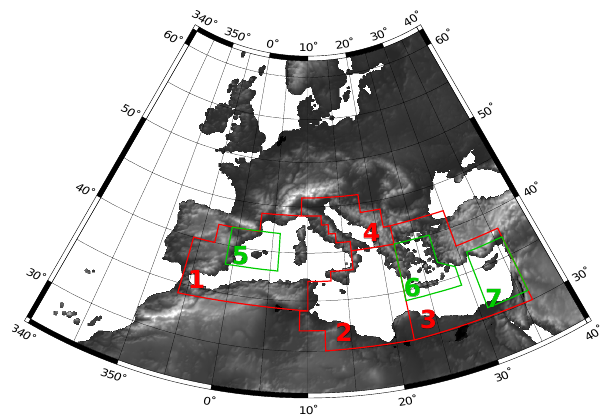
Fig. 1. Definition of the Mediterreanean basin and the seven sub- basins. (1) Western Mediterranean, (2) Central Mediterranean, (3) Eastern Mediterranean, (4) Adriatic Sea, in red as they can be seen as natural boundaries, and (5) the Balearics, (6) the Aegean basin, and (7) the Cyprus basin in green as small, wind-influenced